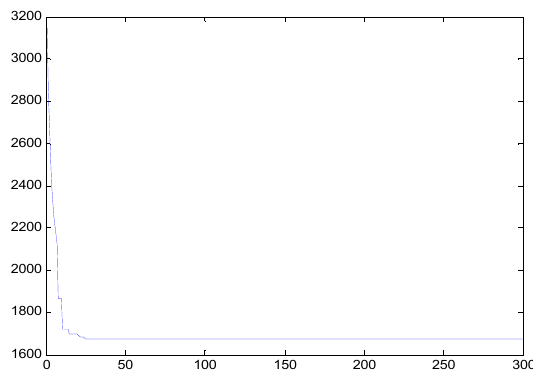
Figure 4. The plot for cost on production manufacturing system in MATLAB.